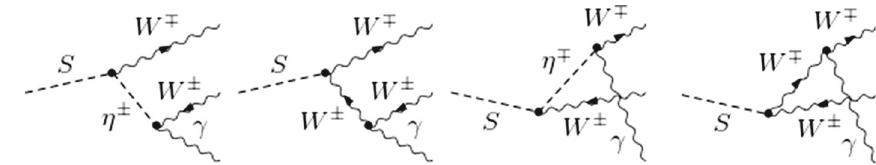
Fig. 1 Feynman diagrams of the photon bremsstrahlung associated to the first-order radiative corrected SW + W − (γ) vertex